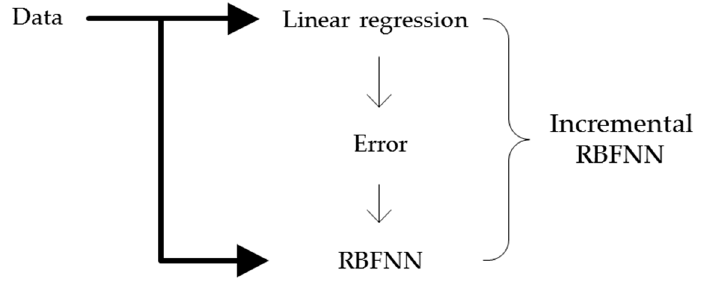
Figure 1. General flow of the development of the incremental RBFNN.